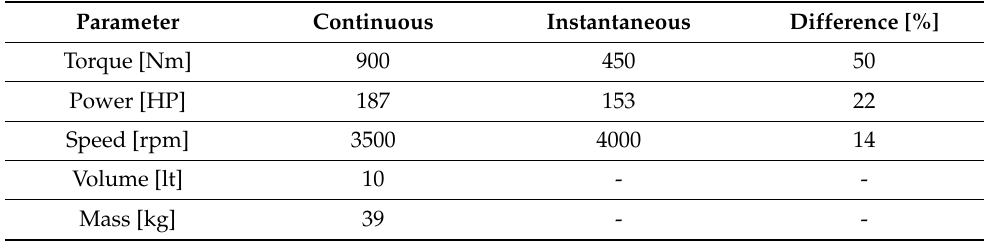
Table 2. Comparison of several MBT